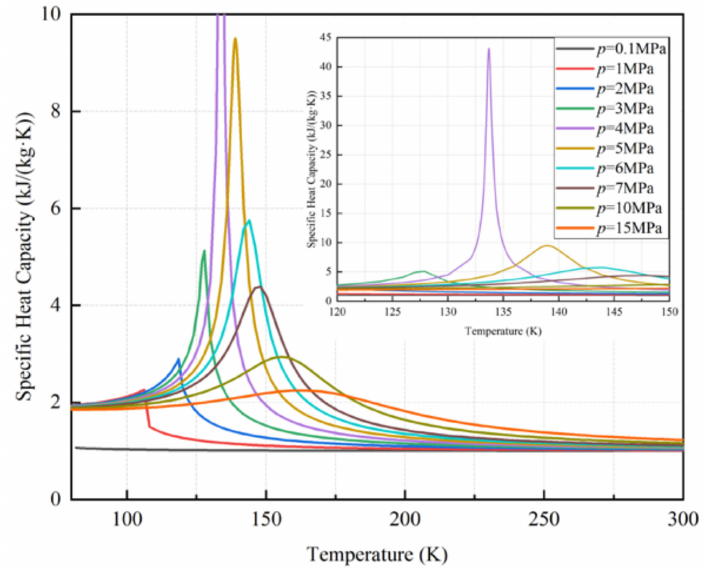
Figure 10. Temperature dependence of the specific heat capacity of air under different